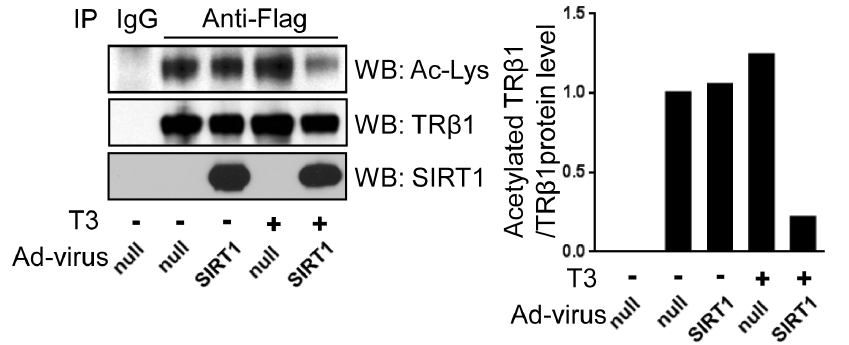
Figure 3. SIRT1 deacetylates TR b 1. Immunoprecipitation analysis of HepG2-TR b 1 cells infected with null adenovirus control or adSIRT1 and treated + / 2 T 3 . TR b 1 was immunoprecipitated with anti-Flag antibodies and precipitates were blotted with anti-acetyl-lysine, TR b 1 or SIRT1 antibodies. IgG control precipitation is shown at right. Acetylated TR b 1 levels relative to total TR b 1 were quantified by Phosphor Imager (right panel).